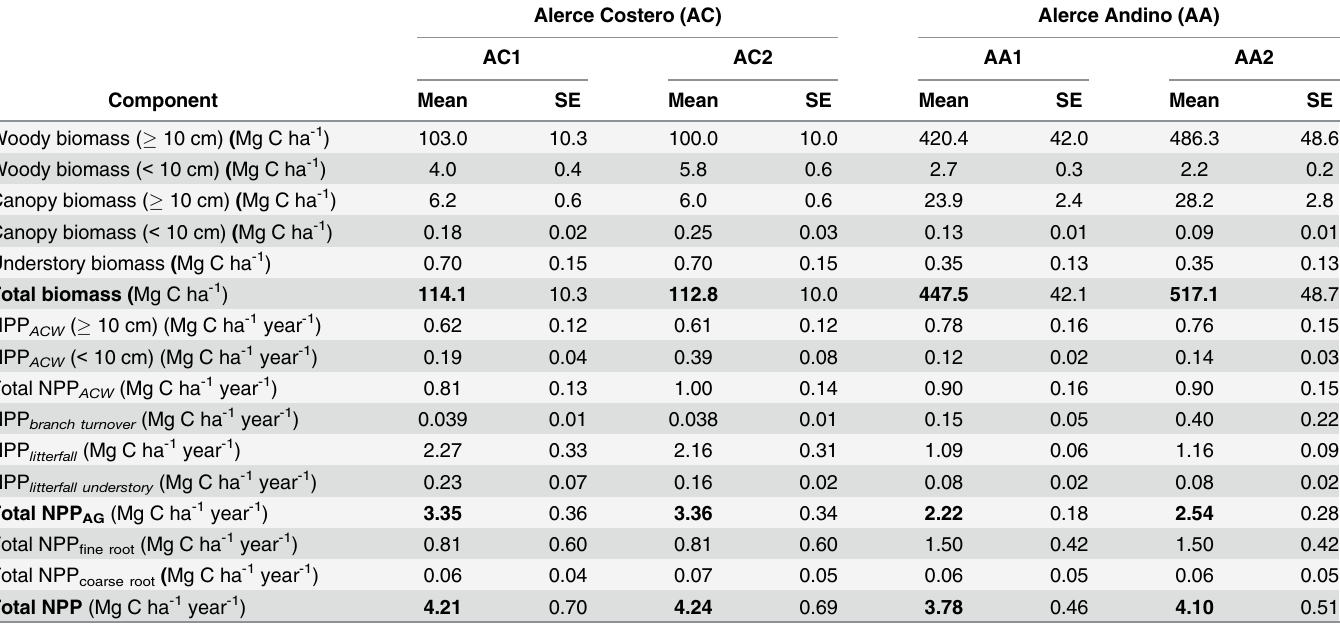
Table 1. Aboveground biomass and productivity per